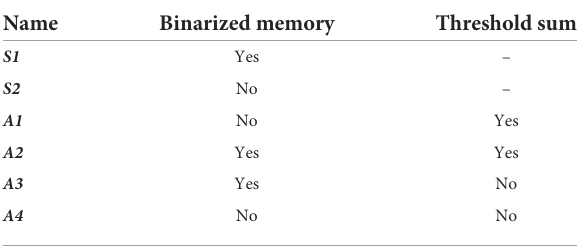
TABLE 1 Variations of superposition vector memory and the